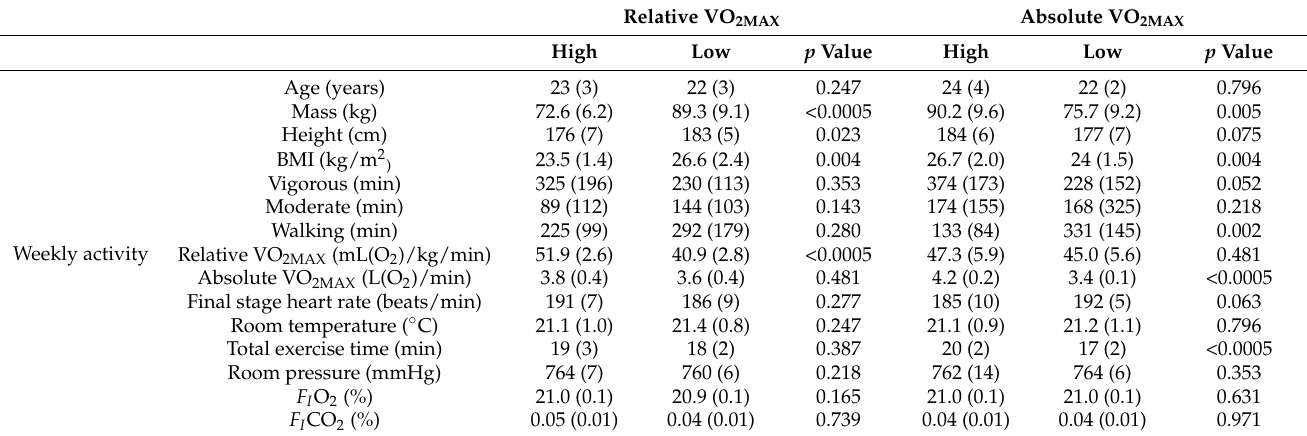
Table 1. Baseline and exercise characteristics of participants and environmental conditions grouped by upper and lower tertiles for relative and absolute maximal oxygen uptake (VO 2MAX